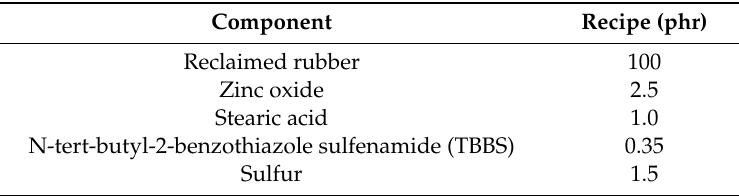
Table 2. Rubber composition for testing reclaimed